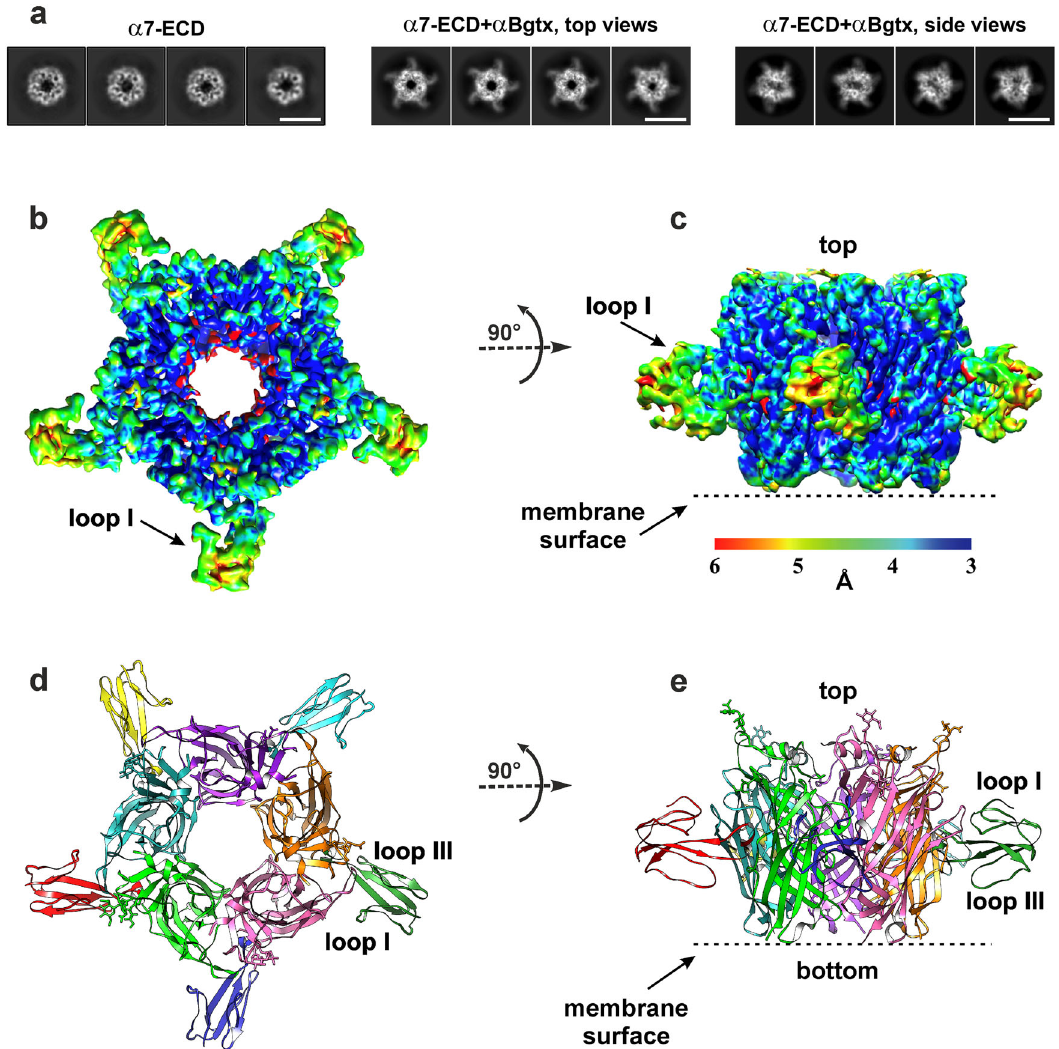
Fig. 1 3D reconstruction of α 7-ECD/ α -Bgtx complex determined by cryo-EM. a Representative 2D class averages for α 7-ECD without and with α -Bgtx. Scalebar is 10 nm. b , c Final 3D density map of the α 7-ECD/ α -Bgtx complex colored with local resolution in top and side views. d , e Crystal structure of the α 7-ECD/ α -Bgtx complex (PDB ID: 4HQP 15 ) is shown for comparison in the same orientation as b , c . Five subunits of α 7-ECD and fi ve α -Bgtx molecules are differently colored. The position of the toxin ’ s loops I and III and expected position of membrane interface in the full-length channel are